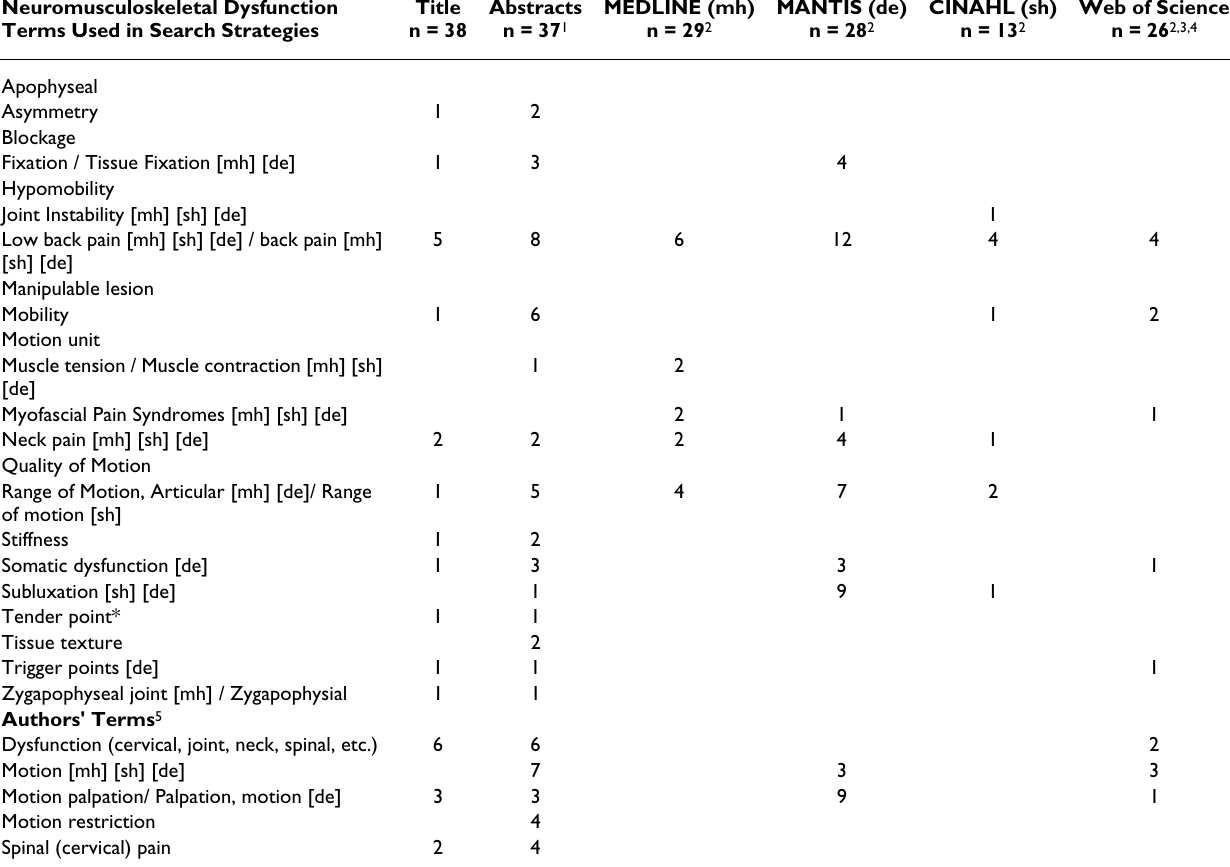
Table 5: Frequency of neuromuscular dysfunction terms in titles, abstracts and four databases Neuromusculoskeletal Dysfunction Terms Used in Search